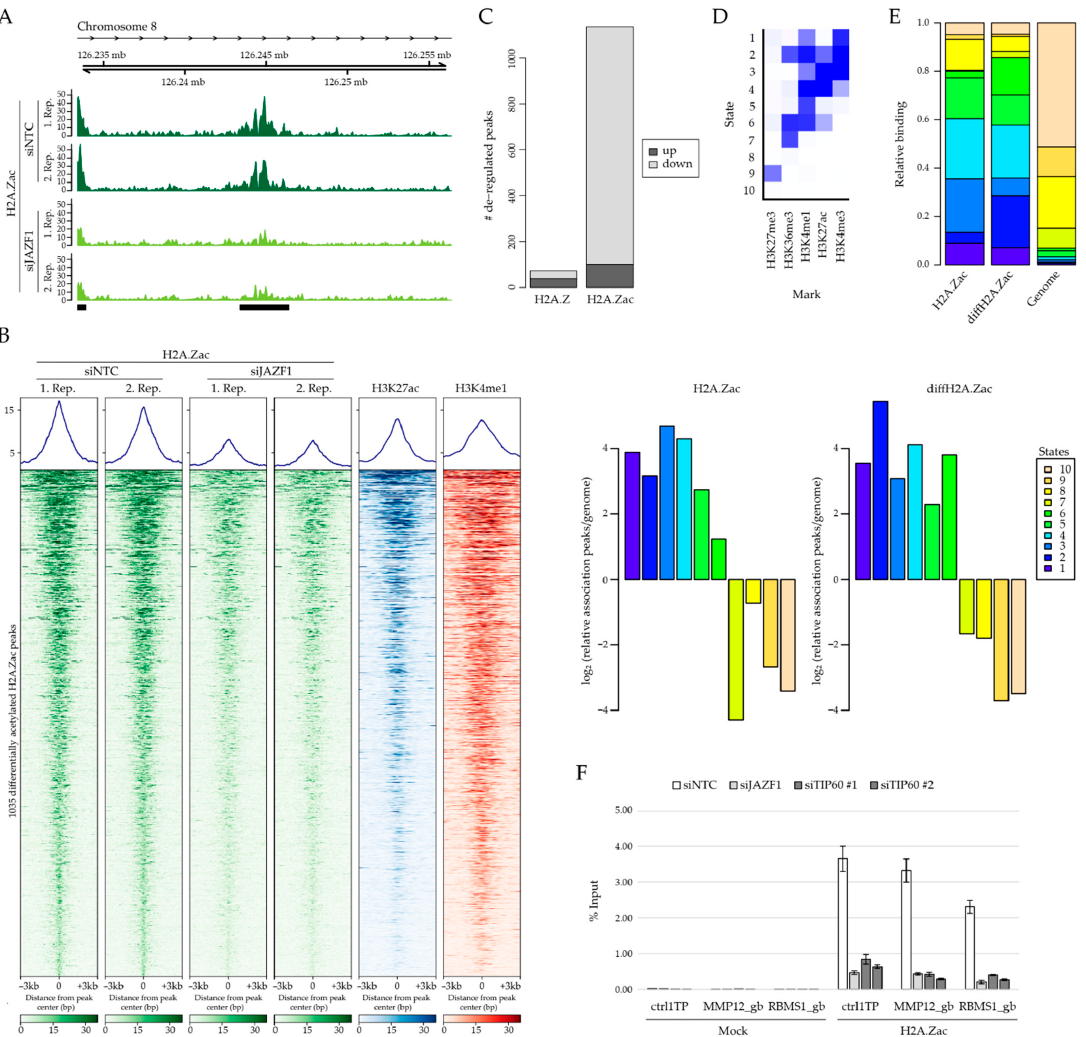
Figure 4. JAZF1 depletion leads to decrease in H2A.Z acetylation at regulatory regions. ( A ) Genome browser snap shot of human chromosome 8 locus as representative region displaying differential H2A.Zac ChIP-seq signals in two replicates of control (siNTC; non-target control siRNA; dark green) and JAZF1 knockdown (siJAZF1; light green). ( B ) ChIP-seq density heatmap of H2A.Zac upon control (siNTC) or JAZF1 (siJAZF1) knockdowns (two replicates, green), as well as visualization of the intensities of H3K27ac (blue, ENCODE) and H3K4me1 (red, ENCODE) at these differentially H2A.Z acetylated regions. Color intensities represents normalized and globally scaled tag counts. ( C ) Bar-plots visualizing deregulated H2A.Z or H2A.Zac peaks upon JAZF1-depletion. Notice that no major change is observed in H2A.Z peaks, but > 1,000 H2A.Zac peaks are downregulated upon loss of JAZF1. ( D ) ChromHMM-based characterization of chromatin states [56,57]. The heatmap depicts the emission parameters of the HMM and describes the combinatorial occurrence of the individual histone modifications (mark) in different chromatin states (1–10). ( E ) Chromatin-state enrichment of global H2A.Zac and differentially deregulated H2A.Zac peaks (diffH2A.Zac) upon JAZF1 depletion in specific states (see ( D )) calculated to frequency in complete genome (right). Notice enrichment of diffH2A.Zac peaks in states 2 and 6 that resemble H3K36me3-positive enhancer regions. See also Supplementary Materials Figure S2F for further characterizations. ( F ) ChIP–qPCR verification of three diffH2A.Zac sites (gb: gene body) upon JAZF1 (light gray) and TIP60 depletion (two independent knockdowns: siTIP60 #1 and siTIP60 #2, dark gray, see also Supplementary Materials Figure S2G for knockdown efficiency), compared to control knockdown (siNTC, white) using no (mock) or H2A.Zac antibodies. Shown is the respective enrichment as percentage of input signals. Error bars represent the SD of three replicates. Notice that TIP60 knockdown also leads to a similar reduction in H2A.Zac at these three diffH2A.Zac sites, compared to JAZF1 depletion. Strikingly, JAZF1 depletion resulted in an overall reduction in the level of H2A.Zac at those particular genomic regions (Figure 4C). In order to determine the identity of